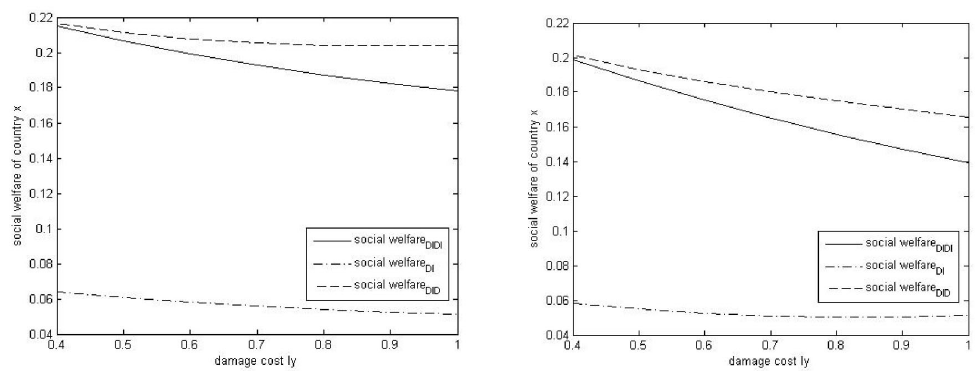
Figure 4. The comparison of R x between scenario DIDI, DI and DID ( l x = 0.5 l y and l x = 0.75 l y